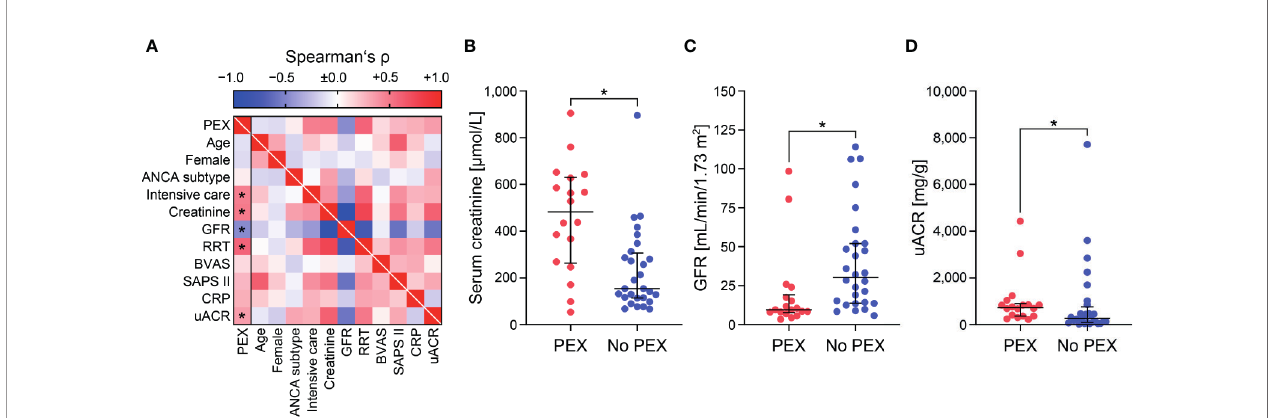
FIGURE 2 | Clinical and laboratory determinants at admission to consider PEX for treatment of severe AAV. (A) Association between initiation of PEX treatment and clinical/laboratory fi ndings are shown by heatmap re fl ecting mean values of Spearman ’ s r , asterisks indicate p <0.05 . (B – D) The scatter dot plots represent medians and IQR with individual data points summarizing association between initiation of PEX treatment and indicated clinical/laboratory fi ndings, Mann – Whitney U-test was used to determine differences in medians and asterisks indicate p <0.05 . AAV, ANCA-associated vasculitis; ANCA, anti-neutrophil cytoplasmic antibodies; BVAS, Birmingham Vasculitis Activity Score; CRP, C-reactive protein; GFR, glomerular fi ltration rate (CKD-EPI); IQR, interquartile range; PEX, therapeutic plasma exchange; RRT, renal replacement therapy; SAPS II, simpli fi ed acute physiology score II; uACR, urinary albumin/creatinine